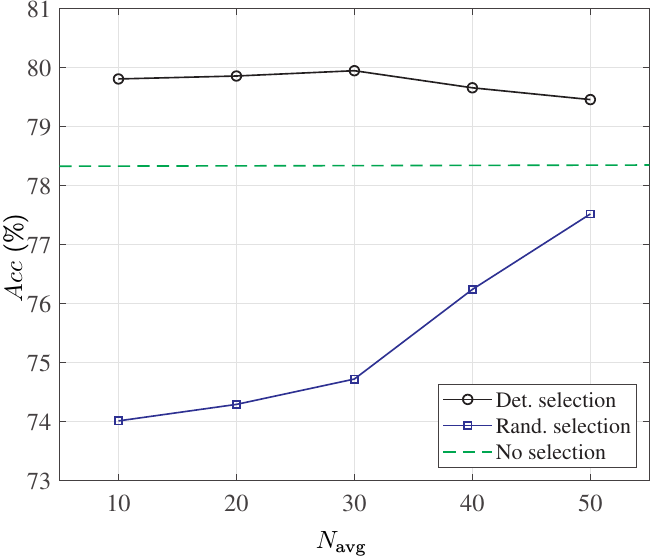
Figure 6. The accuracy of the random forest classifier vs. the number of averaged fragments for two fragment selection strategies. The case of no-selection (green line) corresponds to averaging all the available